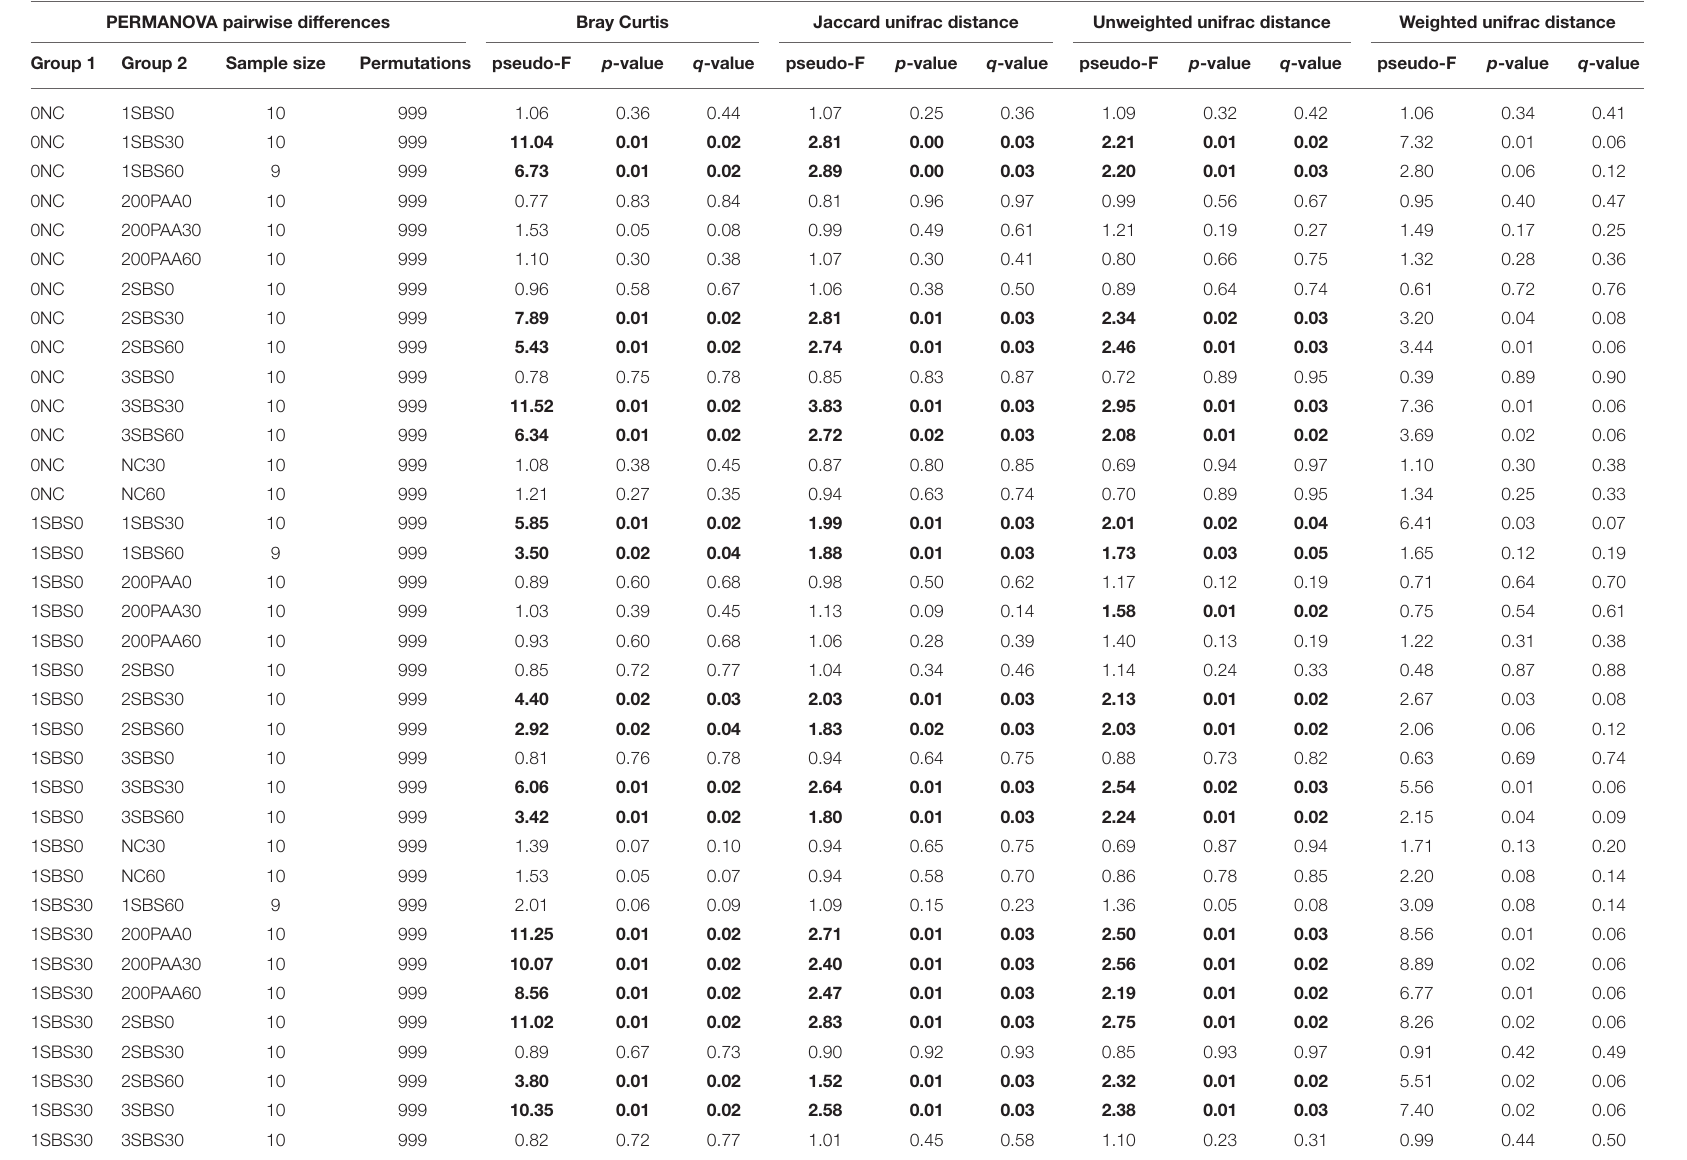
TABLE 2 | PERMANOVA differences in beta diversity indices whose main effects were